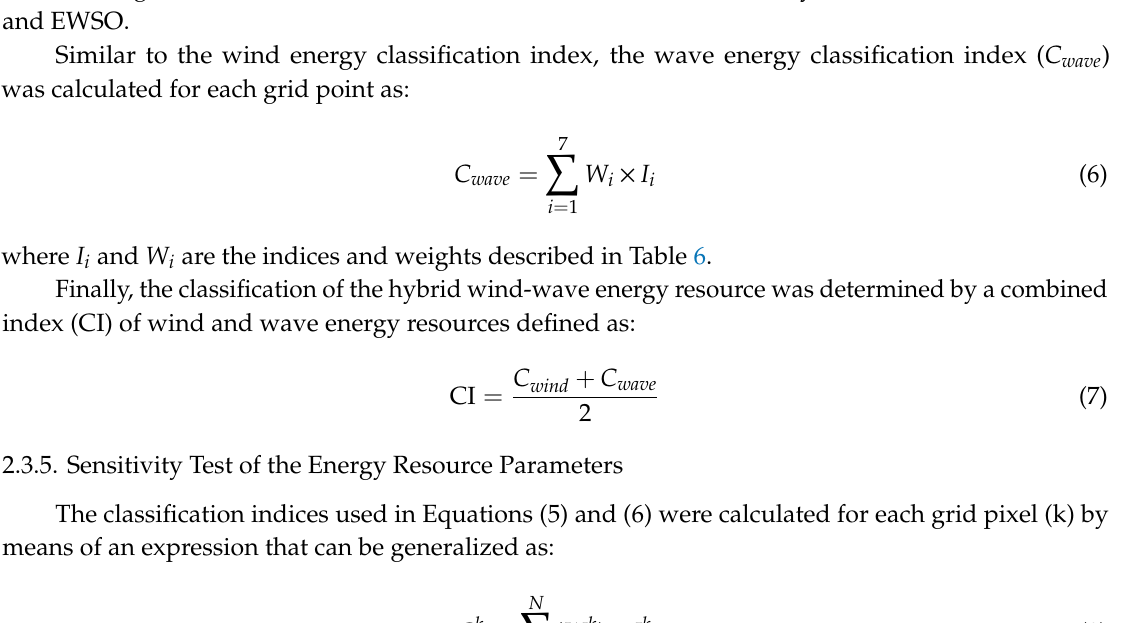
(cid:113) (cid:12) (cid:12) (cid:80) N 2 (cid:12) (cid:12) / N , (cid:12) A i − A (cid:12) i = 1